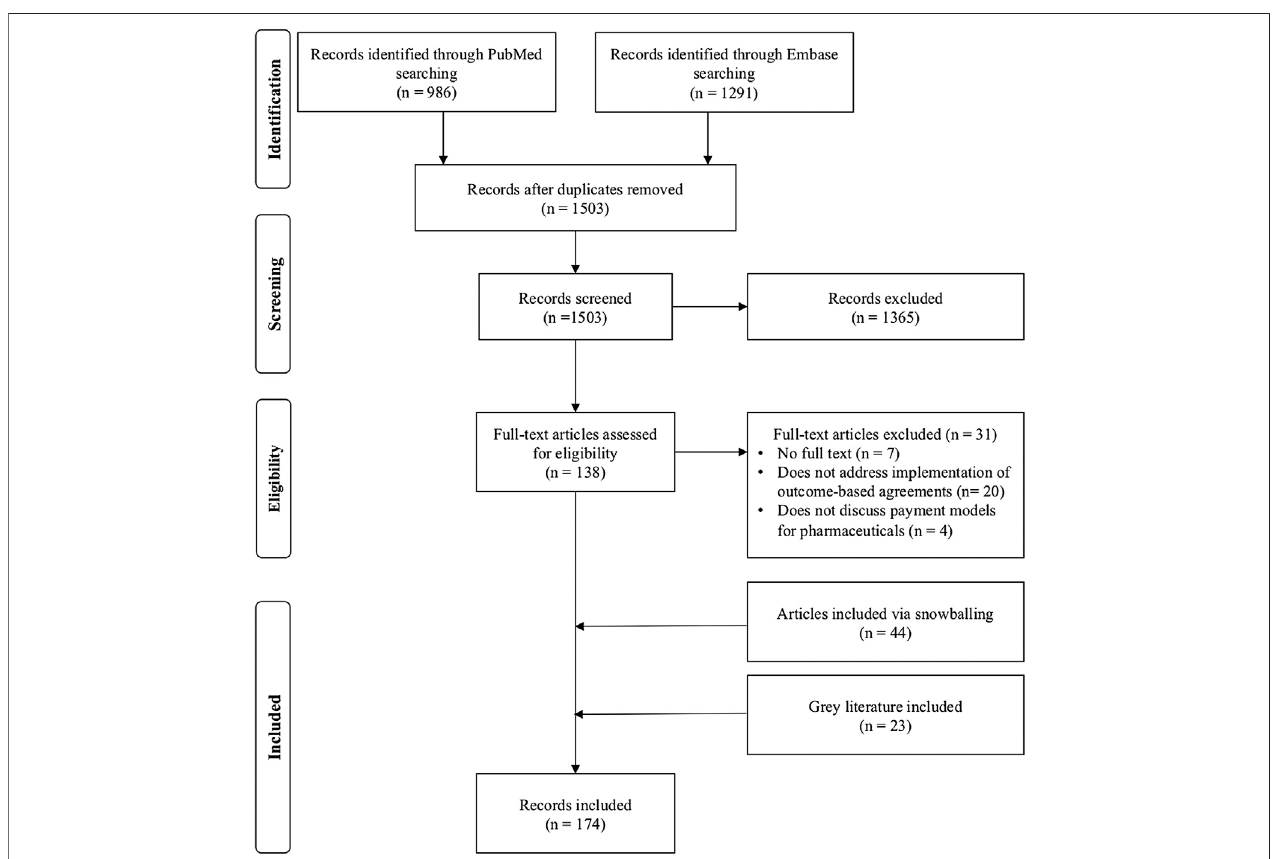
FIGURE 1 | PRISMA diagram of the literature search and inclusion of